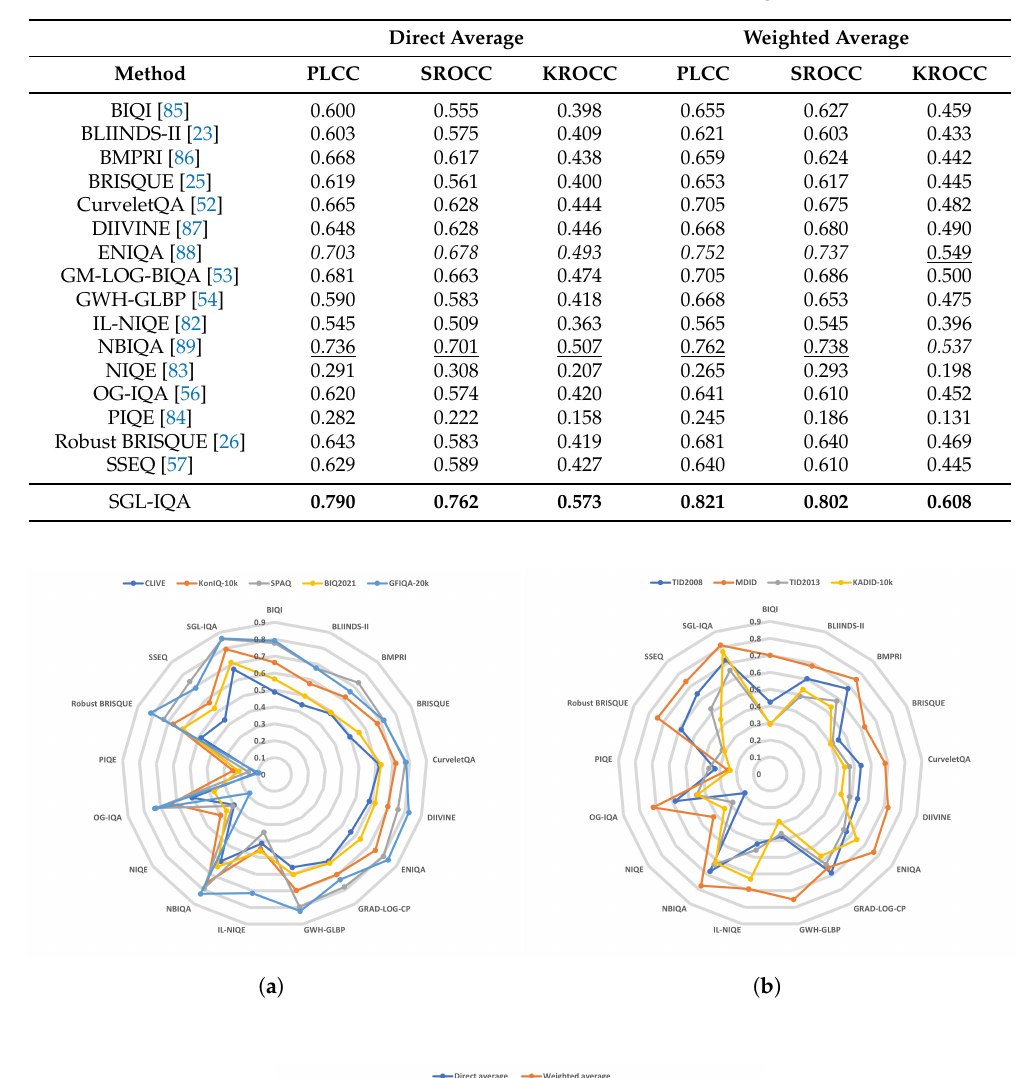
Table 8. PLCC , SROCC, and KROCC direct and weighted averages. The best results are given in bold, the second-best results are underlined, and the third-best results are given in italics.